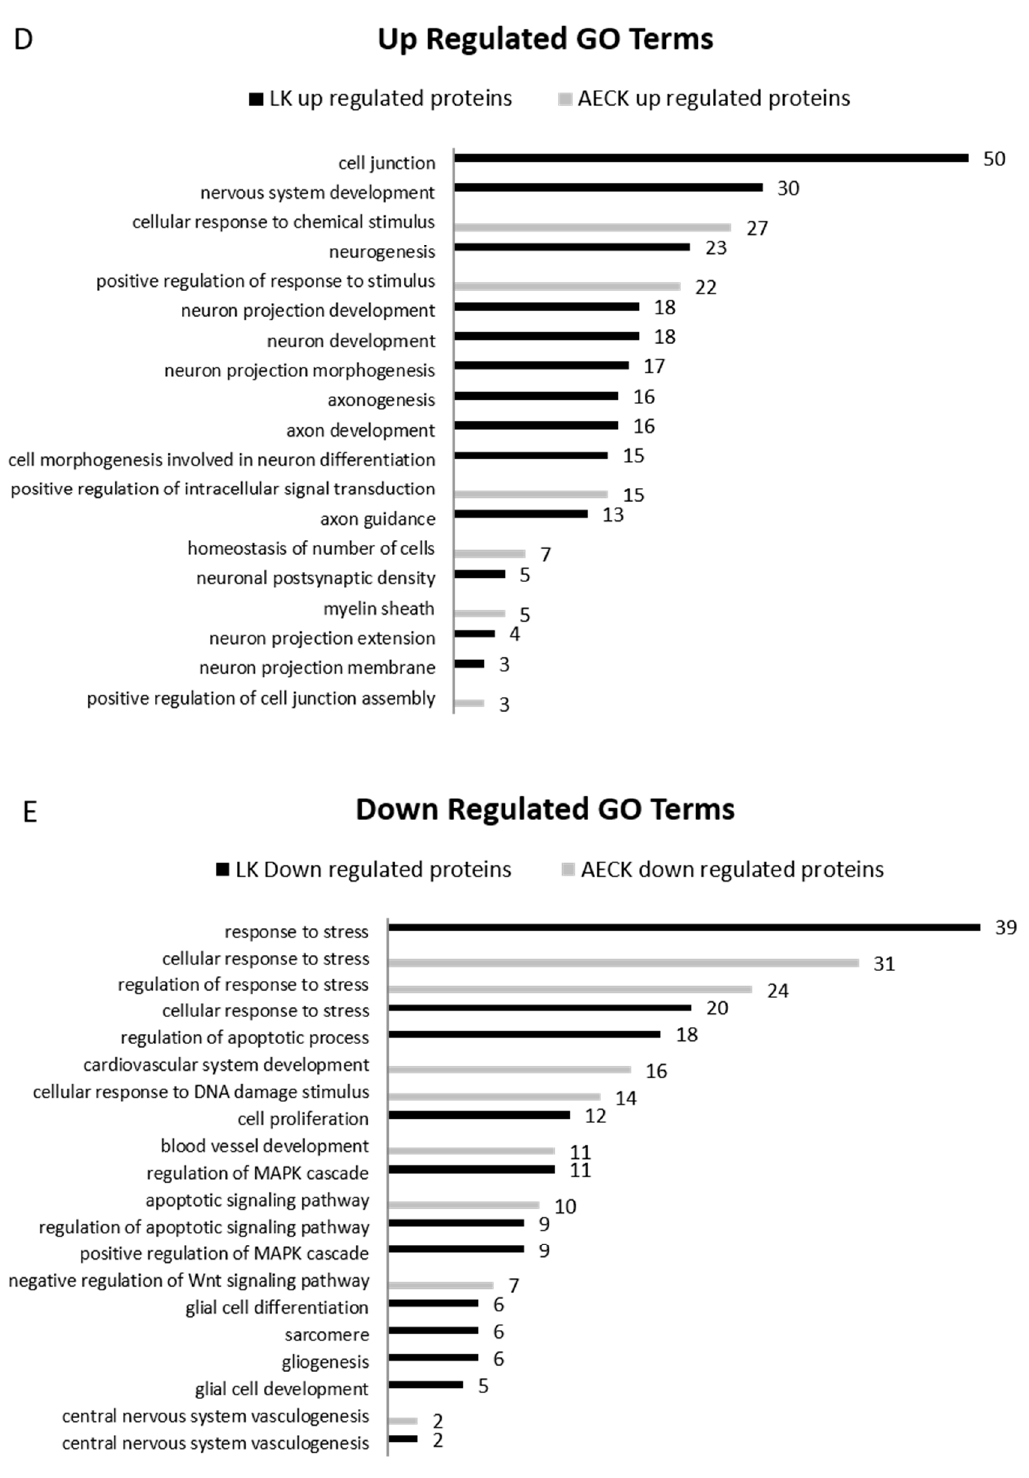
Figure 3. Interaction Networks ( A ) Presents the iTRAQ dataset of 2430 unique proteins nodes each individually colored with a cumulative 90,855 annotated or canonical interactions between proteins across the network presented in grey edge lines. ( B ) Presents the iTRAQ dataset of the full network with all up-regulated protein nodes present in blue and down-regulated protein nodes in red. ( C ) Presents the AECK unique protein nodes as “triangles”, LK protein nodes as squares and shared protein nodes as “circles”. This is in conjunction with the color indication of up regulated proteins in blue and down regulated in red. ( D , E ) number of up and down regulated proteins by GO terms respectively.